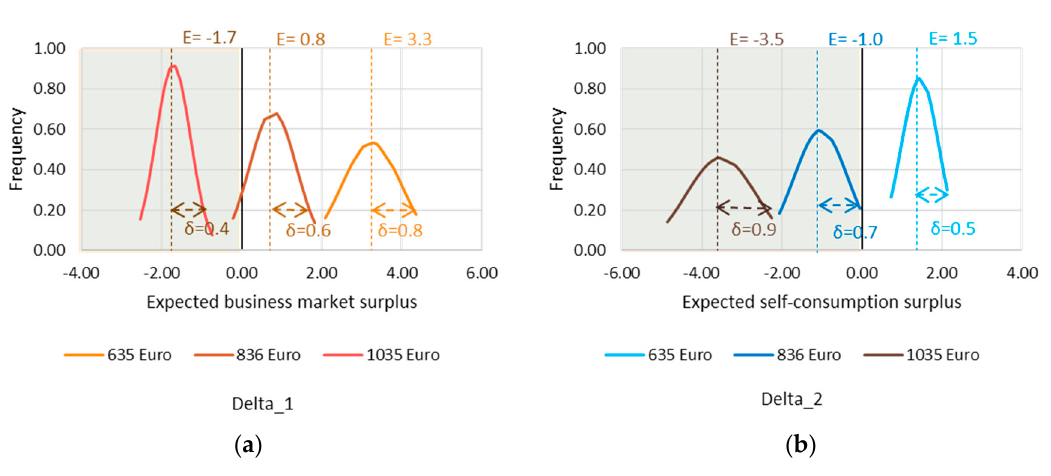
( b ) Figure 14. Competitive prices change in accordance with the projected grid tariff increases from ( a ) 7.2 to ( b ) 8.7 Euro cent/kWh. In this paper, we observe the effect of the reduction in specific investment for rooftop PV in Vietnam by adjusting the capital expenditure (CAPEX) of the small rooftop PV systems (1–15 kWp), which will also affect O&M costs (OPEX). The current total costs (CAPEX + OPEX) range from 635 to 1038 Euros/kWp in Vietnam. At a discount rate of 8% and under the FIT 1.0 or FIT 2.0, the business project can expect an average benefit ranging from − 1.7 to 3.3 Euro cent/kWh and the self- consumption project can expect from − 3.5 to 1.5 Euro cent return per kWh (Figure 15). If the total cost is lower than 650 Euros/kWp, it is feasible to invest in either of the metering models. However, the